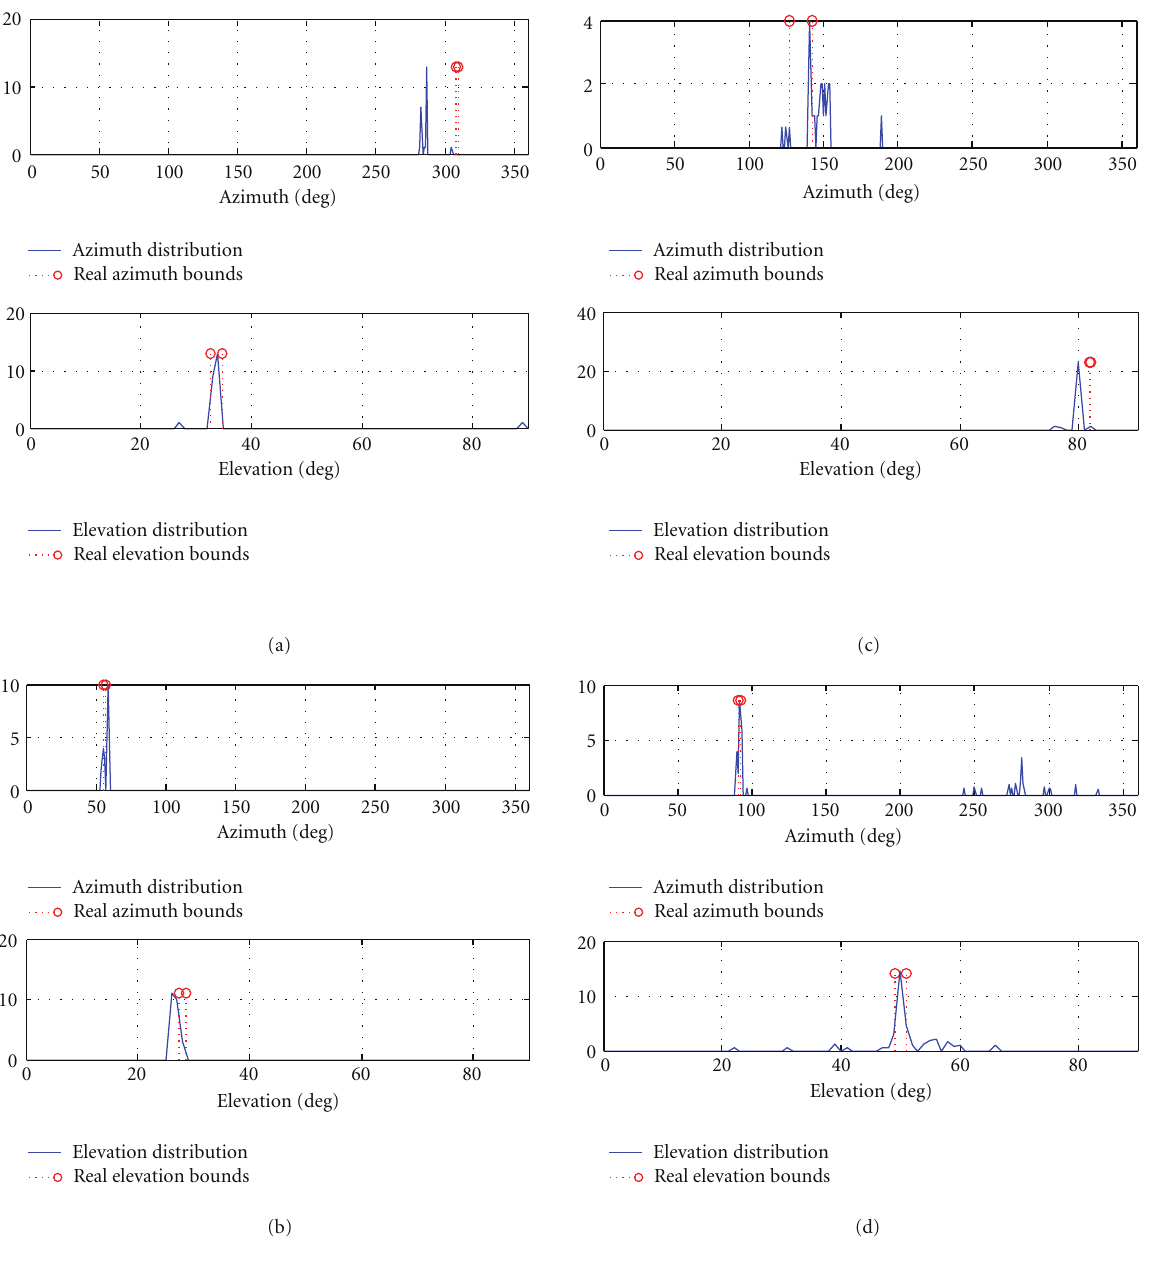
Figure 8: Measured AS along azimuth and elevation angles in the urban canyon, for di ff erent PRNs.